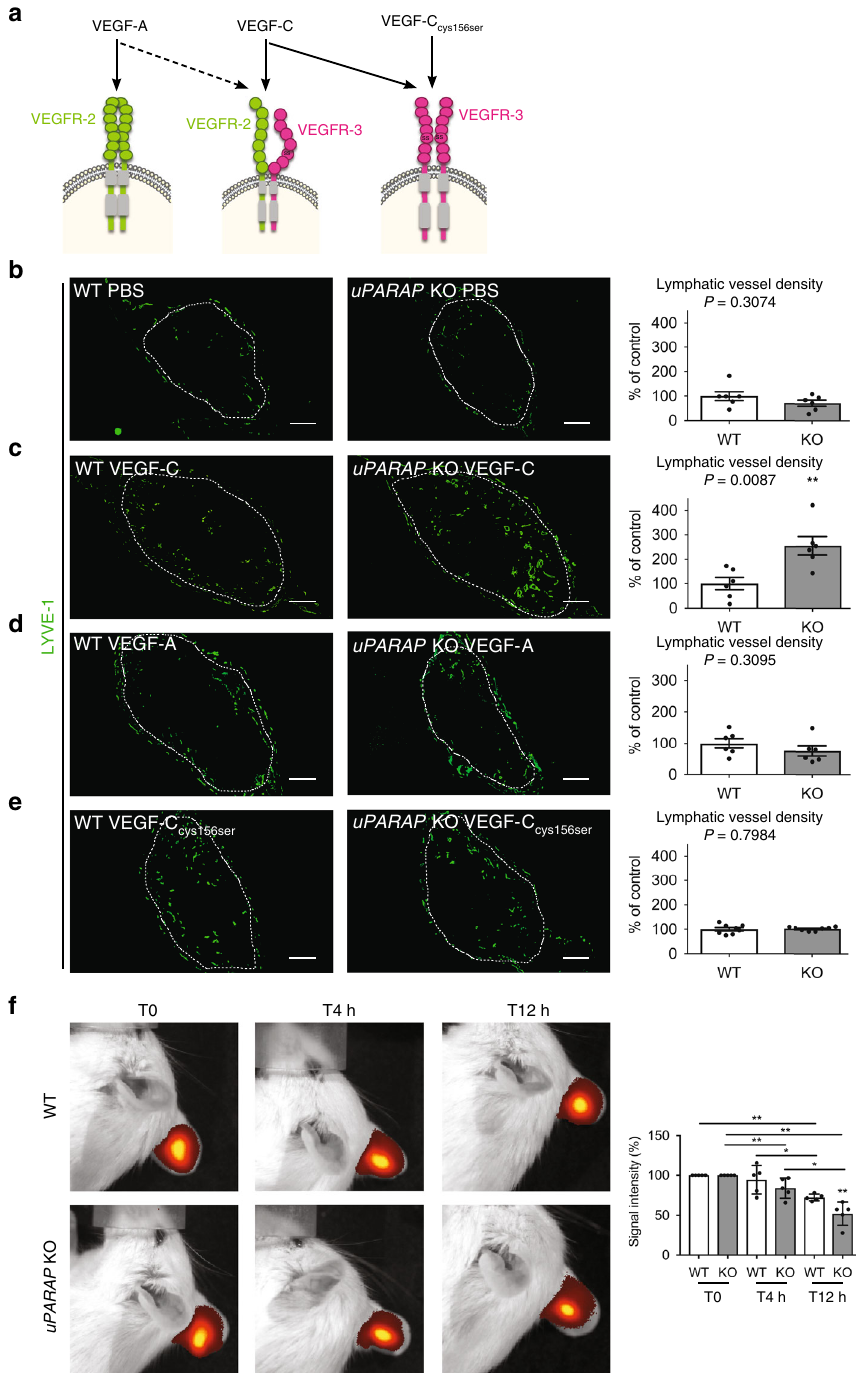
Fig. 2 uPARAP de fi ciency stimulates VEGF-C-driven lymphangiogenesis. a Schematic of VEGF ligand interaction with VEGFR-2 and VEGFR-3 homodimers or VEGFR-2/VEGFR-3 heterodimers. b – e Gelatin sponges soaked with PBS ( b ), VEGF-C ( c ), VEGF-A ( d ), or mutated VEGF-C Cys156Ser ( e ) were implanted in mouse ears. White dots delineate the sponge in the ear. Lymphatic vasculature was examined by LYVE-1 (green) immunostaining. Histograms represent the area density of vessels quanti fi ed by a computer-assisted method and expressed as percentage of WT control ( b – d n = 6; e n = 8). Bars = 500 µ m. f Indocyanin Green (ICG) clearance in VEGF-C-soaked sponges in uPARAP WT and KO mice using Xenogen IVIS. Histogram represents mean fl uorescence signal detected at each time point ( n = 5). All results are expressed as mean ± SEM, and statistical analyses were performed using a non-parametric Mann – Whitney test. * P < 0.05 and ** P < (Fig. 5h). Interestingly, in the presence of uPARAP, VEGFR-2/ by a computerised method (Fig. 5i). Indeed, heterodimers were VEGFR-3 heterodimers were also mainly detected in the leading mainly localised in front of the nucleus in cells expressing edge of migrating cells. In sharp contrast, upon uPARAP uPARAP and migrating in a gradient of VEGF-C (70% of silencing, heterodimers were spatially redistributed as determined heterodimers localised in front of the nucleus). Upon uPARAP